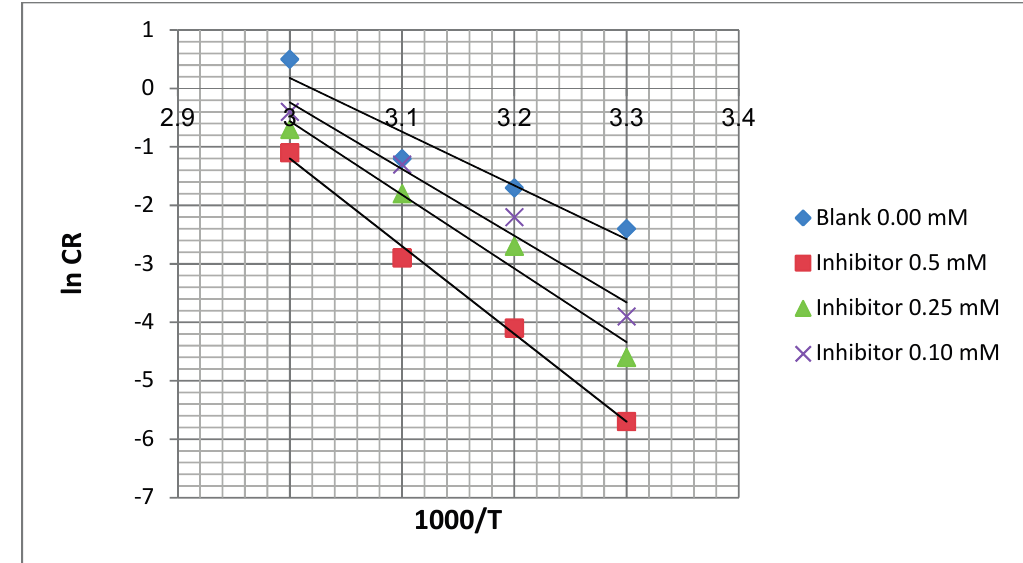
Figure 6. Arrhenius plot for mild steel in 1.0 M HCl.